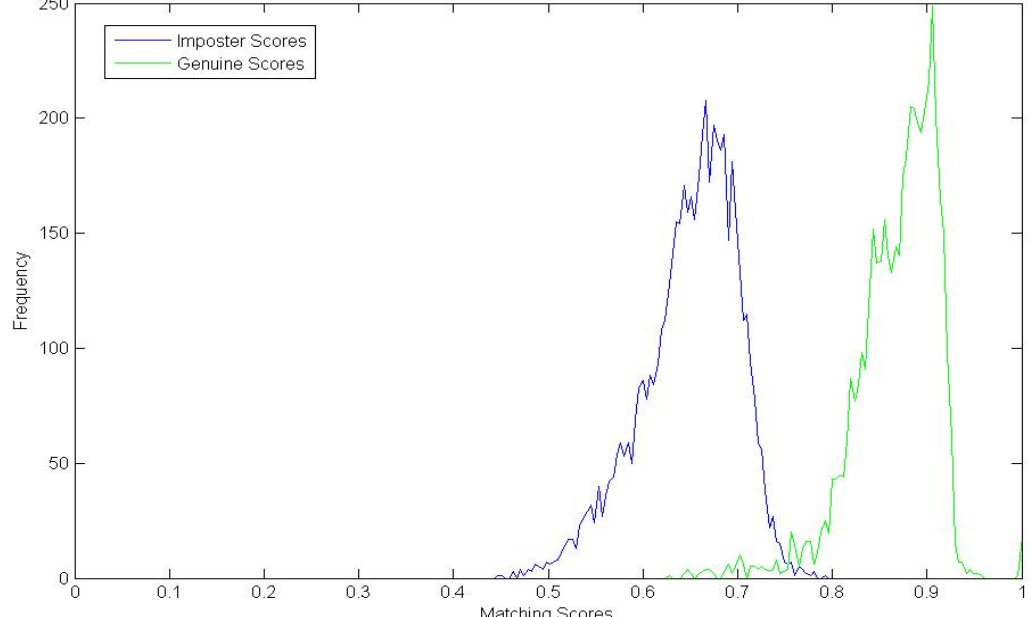
Figure 7. Genuine and imposter matching score distributions by LBP.